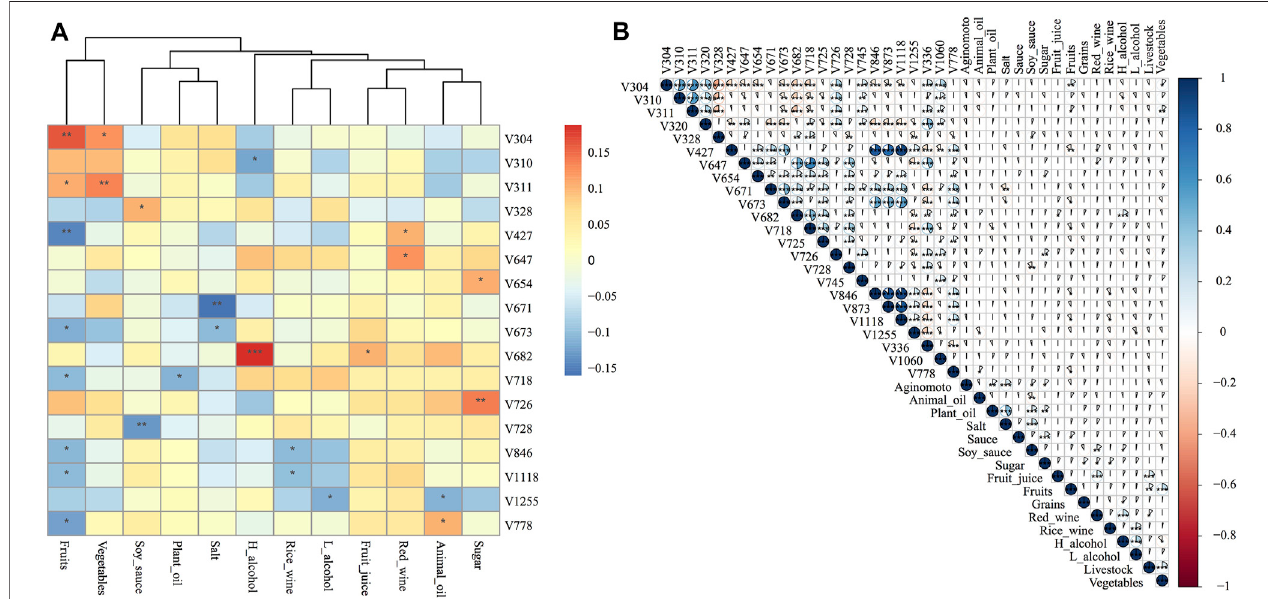
FIGURE 5 | Correlation analysis between relative abundance of core bacterial taxa and meta data in clinical study.